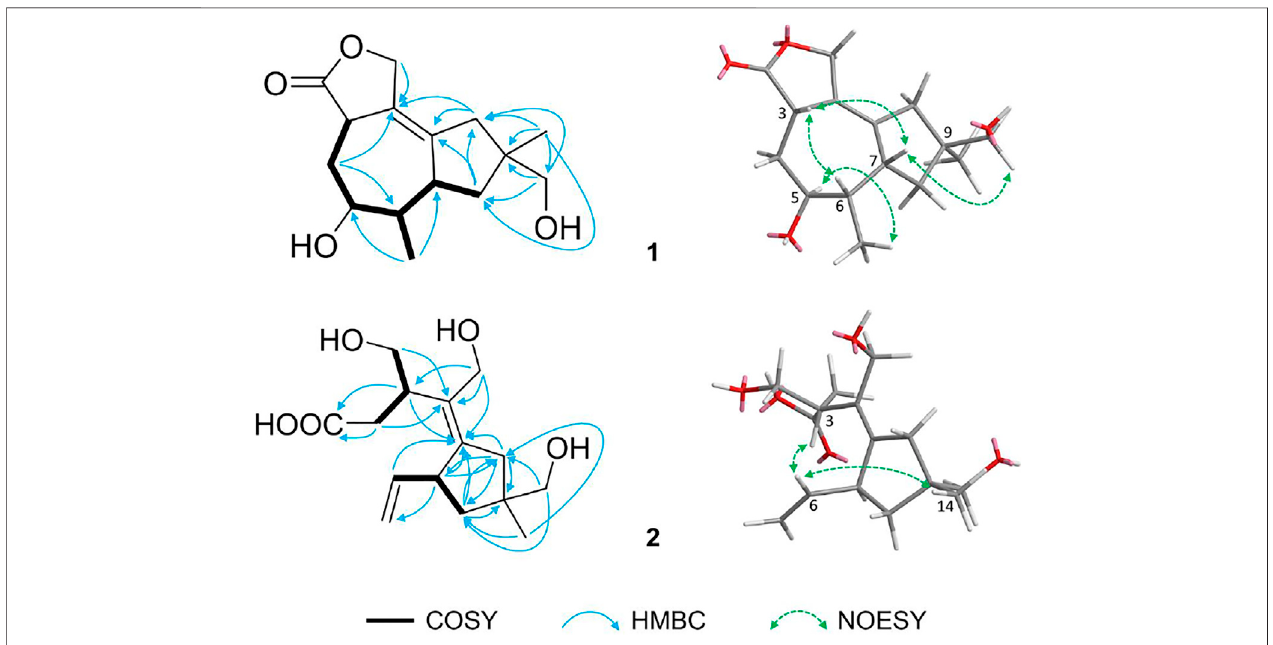
FIGURE 2 | Key 1 H – 1 H COSY